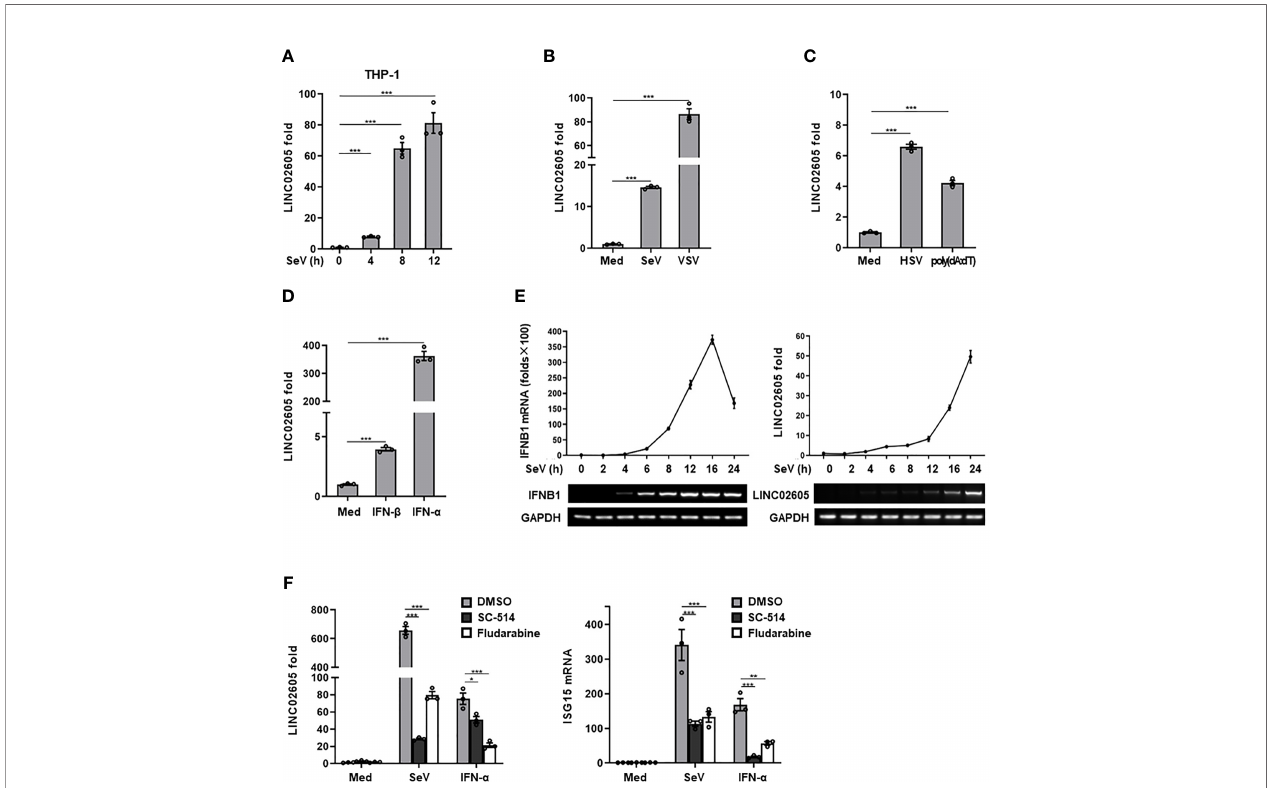
FIGURE 1 | LINC02605 is upregulated by viral infection or type I IFN stimulation. (A) Q-PCR analysis of LINC02605 expression in THP-1 cells infected with SeV for the indicated hours. (B – D) Q-PCR analysis of LINC02605 expression in HEK293T cells infected with RNA virus (SeV, VSV) (B) , DNA virus (HSV) for 12h, stimulated with DNA virus analogue poly (dA:dT) for 12h (C) , or I-IFNs for 12h (D) . (E) Q-PCR analysis of IFNB1 and LINC02605 mRNA expression in HEK293T cells infected with SeV for the indicated times. (F) Q-PCR analysis of LINC02605 and ISG15 expression in HEK293T cells pretreated for 1h with the IKK-2 inhibitor SC-514 (100 m M) or the STAT1 inhibitor Fludarabine (1.5 m M), then treated with SeV or IFN- a for 12h. All data shown are from one representative experiment of at least three independent repeats with similar results. * P < 0.05, ** P < 0.01 and *** P < 0.001 (Student ’ s t-test or